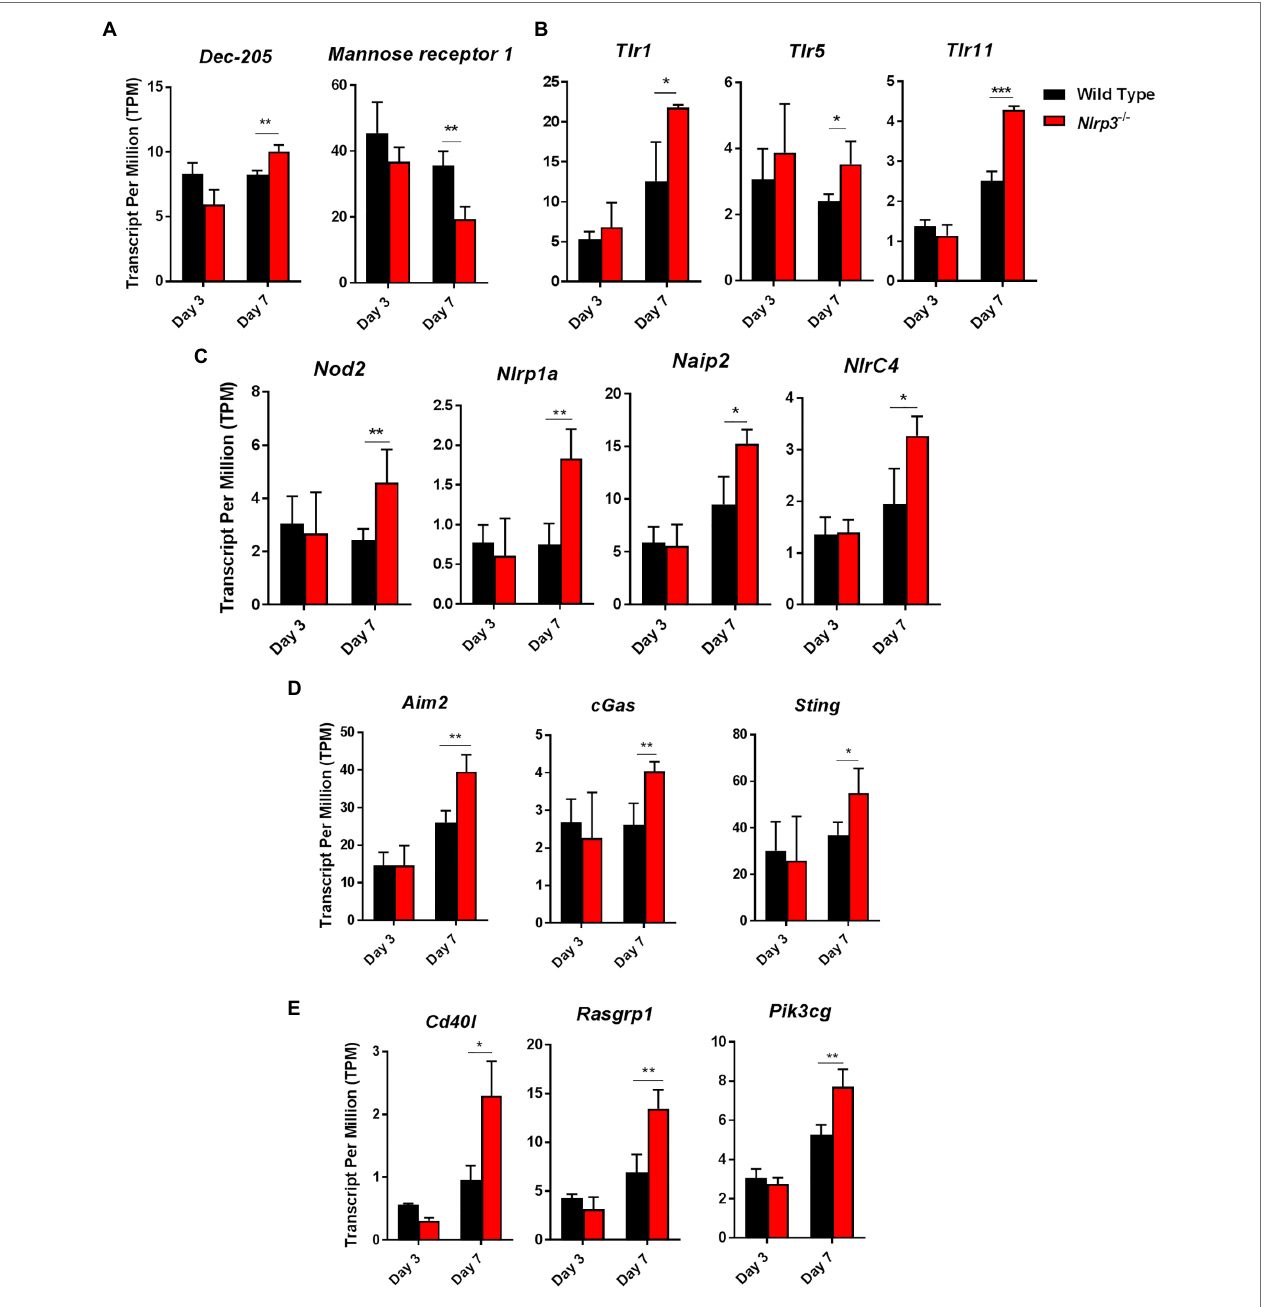
FIGURE 9 | The key innate immune pathway genes are differentially expressed in Nlrp3 − / − infected with F. tularensis LVS. Expression levels of C-type lectin receptors (Clrs) (A) , Tlrs (B) , Nlrs (C) , DNA sensors (D) , and components of NF- κβ and MAPK-signaling pathways (E) in wild-type and Nlrp3 − / − mice infected with 1 × 10 4 CFUs of F. tularensis LVS on days 3 and 7 post-infection. Data shown are cumulative of transcript levels using RNA isolated from lungs of F. tularensis- infected mice ( n = 3/time point/group) on days 3 and 7 post-infection. The data are presented as transcripts per million (TPM) and analyzed using unpaired t -test and a p- value of 0.05 or less was considered significant. * p > 0.05; ** p > 0.01; *** p >